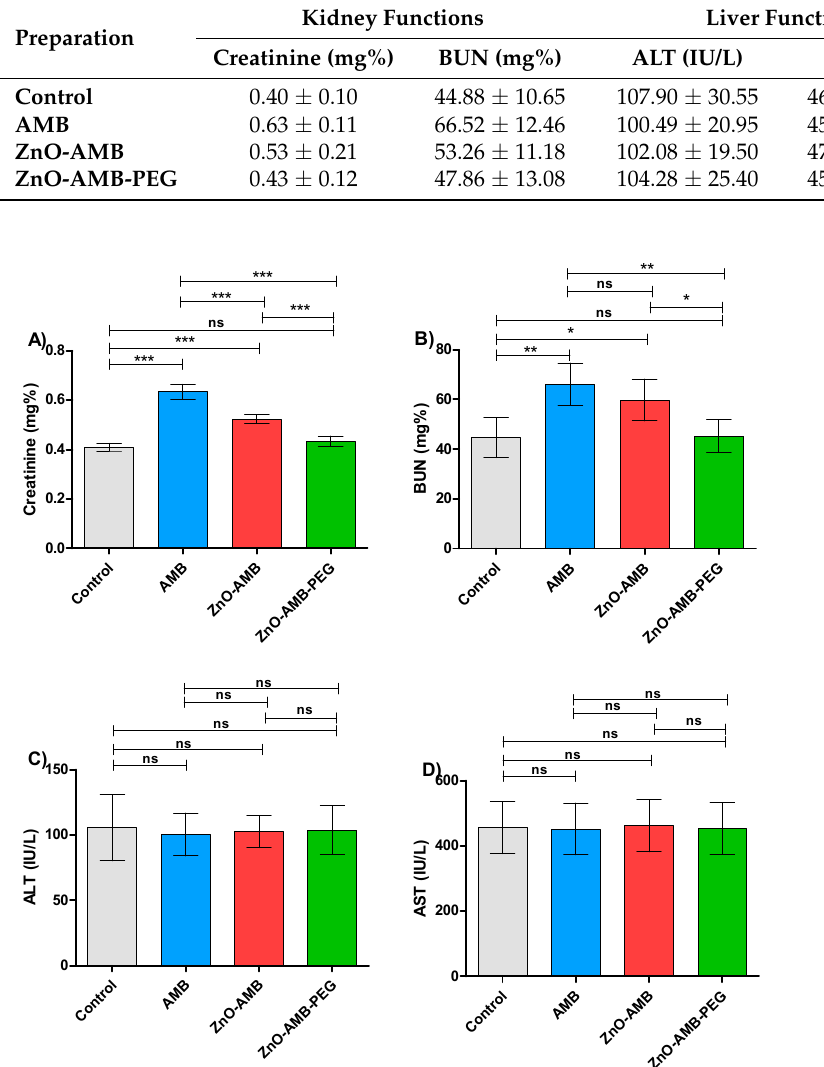
Figure 7. Biochemical parameters. Four groups of rats ( n = 5) were injected intraperitonially with 10 mg/kg seven doses of free AMB, ZnO-AMB or ZnO-AMB-PEG or kept uninjected, then, kidney and liver functions were evaluated ( A ; Creatinine concentration, B ; BUN concentration, C ; ALT concentration, D ; AST concentration). The assays were conducted in triplicate and one-way ANOVA test followed by Tukey’s multiple comparison post hoc test were used to attest the significance. The PEGylated ZnO-AMB did not significantly increase the levels of kidney function markers creatinine and BUN in comparison to control group. Meanwhile, ZnO-AMB-PEG significantly decreased the levels of kidney markers in comparison to ZnO-AMB and free AMB. One the other hand, there was insignificance between liver enzymes ALT and AST in different groups. * = p < 0.05, ** = p < 0.01 and *** = p < 0.001, ns = non-significant.